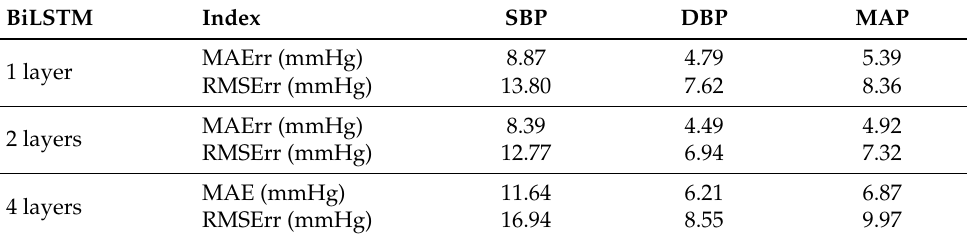
Table 6. Comparison of the Number of BiLSTM layers in the Backbone Multitask Method.